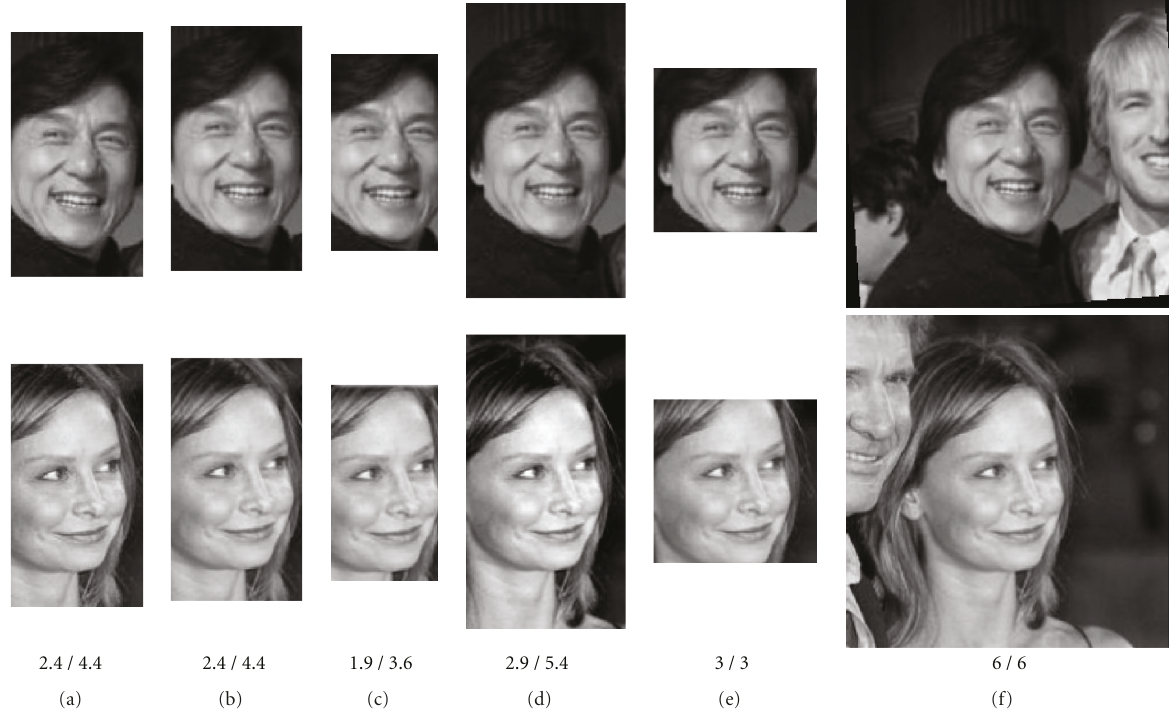
Figure 4: Examples of faces with di ff erent cropping (LFW database). (a) 100 × 185, unaligned; (b) 100 × 185, aligned; (c) 81 × 150, aligned; (d) 122 × 225, aligned; (e) 125 × 125, aligned; (f) 250 × 250, aligned. The last row shows the normalized image’s width and height ( nw / nh ). The images are shown maintaining their relative